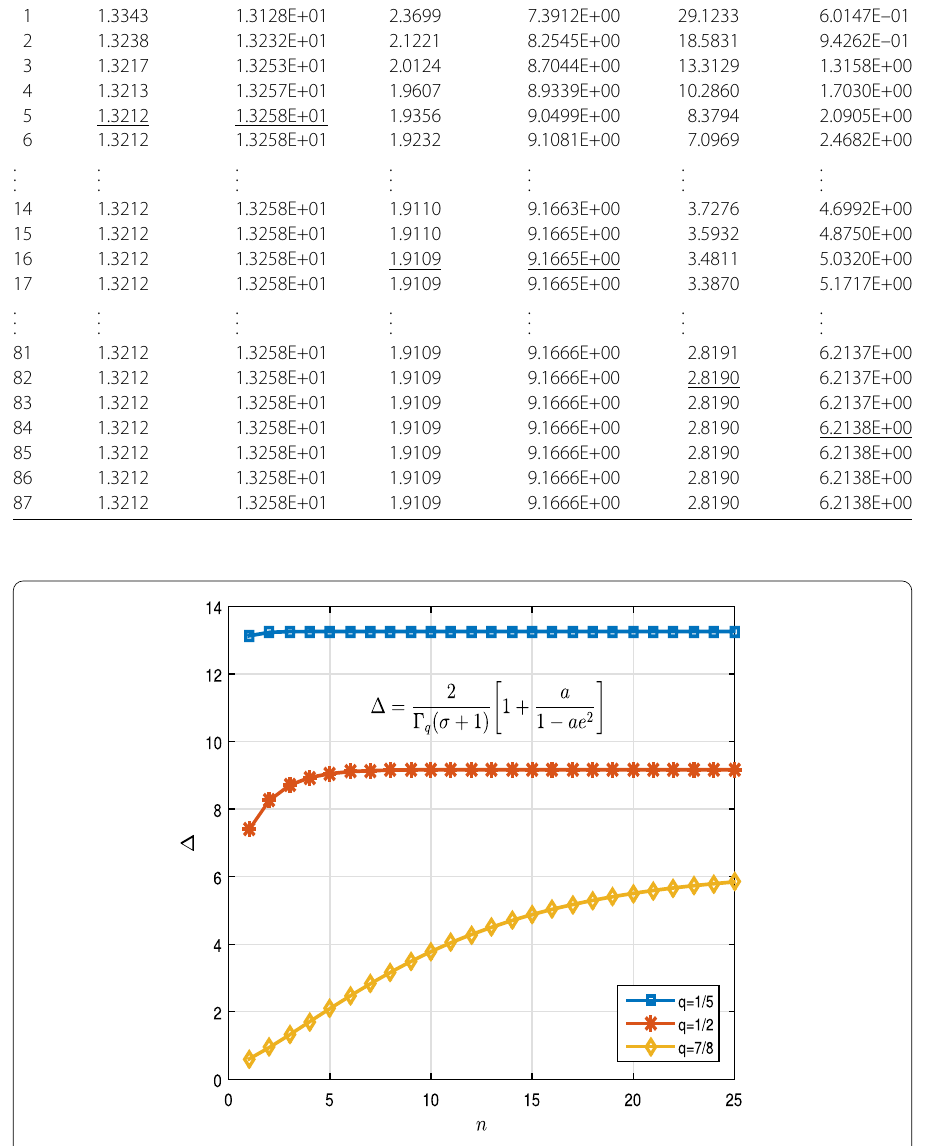
Figure 2 2D graphs of (cid:14) for q = 1